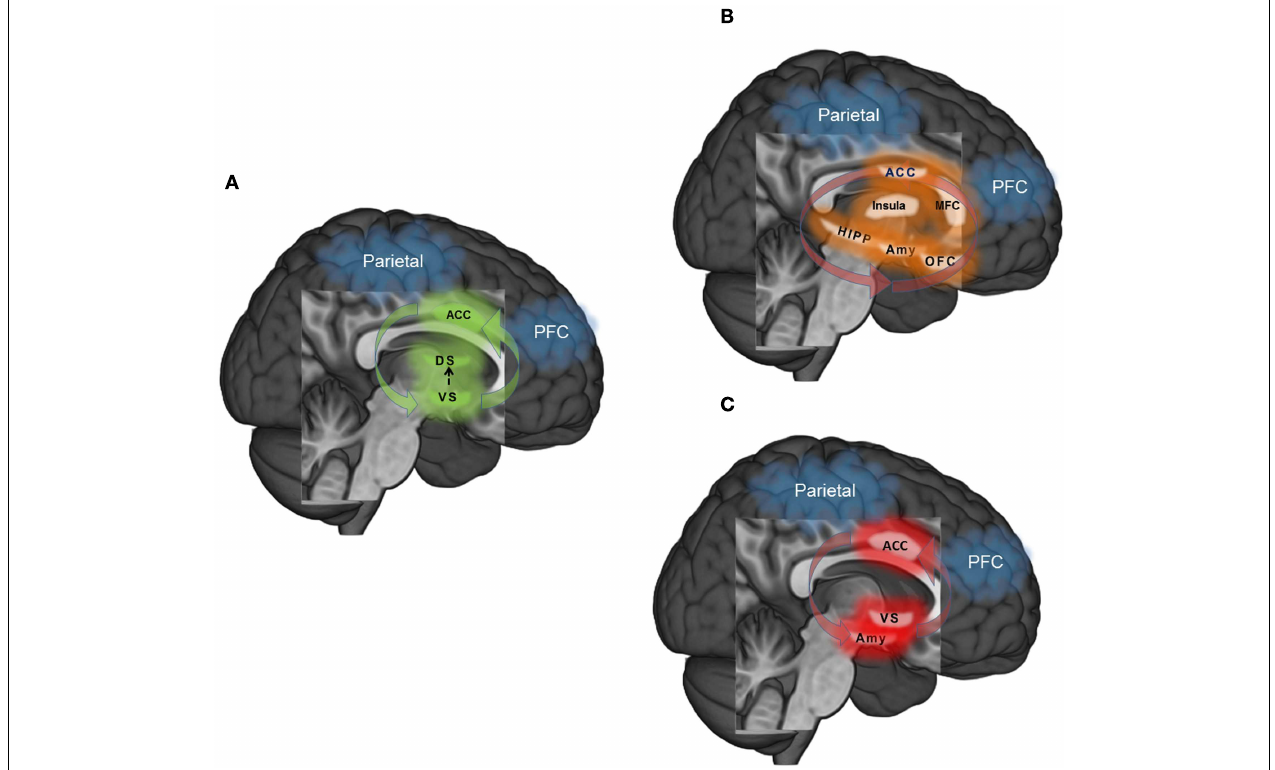
cue, amygdala (Amy) during emotional arousal, hippocampus (HIPP) during coding of context, insula during interoception and orbitofrontal cortex (OFC) in weighing the cost – benefit ratio of relieving craving through drug use or remaining abstinent. Functional disconnectivity of the fronto-parietal network with these regions may strengthen craving by dysregulating responses to craving triggers. (C) Unregulated affect: Dysregulated affect may ensue when there is inefficient or attenuated top-down control from fronto-parietal circuitry into the amygdala (Amy) in the context of negative emotions, and ventral striatum (VS) in the context of reward. Disconnectivity between the anterior cingulate cortex (ACC) and prefrontal cortex along with hyperconnectivity of the ACC and limbic-striatal regions may potentiate this